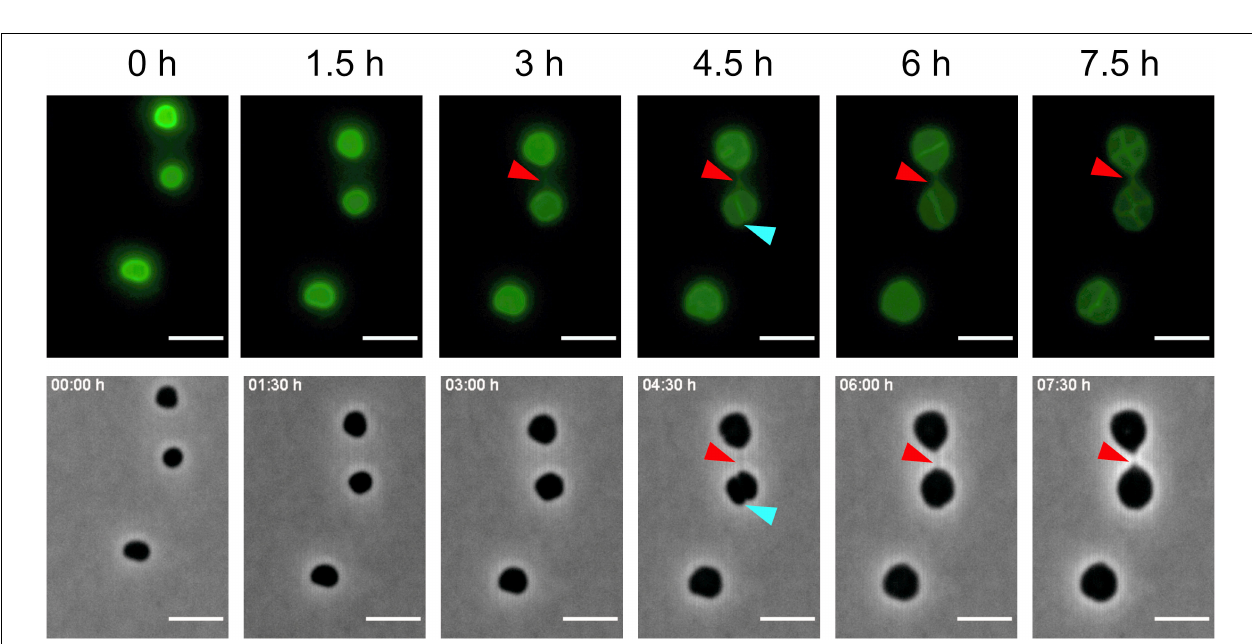
FIGURE 4 | Detection of macromolecular complexes in cell–cell bridges. (A) A micrograph of a targeted cell–cell bridge shows the presence of ribosomes in the cell–cell bridge (as indicated by red arrows). (B) The left panel shows the magnified tomographic slice of the cell–cell bridge and shows the ribosomes arranged in a chain-like manner (as indicated by red arrows). The right panel shows another slice of the selected cell–cell bridge showing a long filamentous structure inside the cell–cell bridge (as indicated by blue arrows). Scale bars are 100 nm.